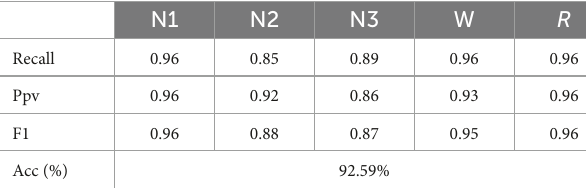
of connectivity in different sleep stages, where the red line